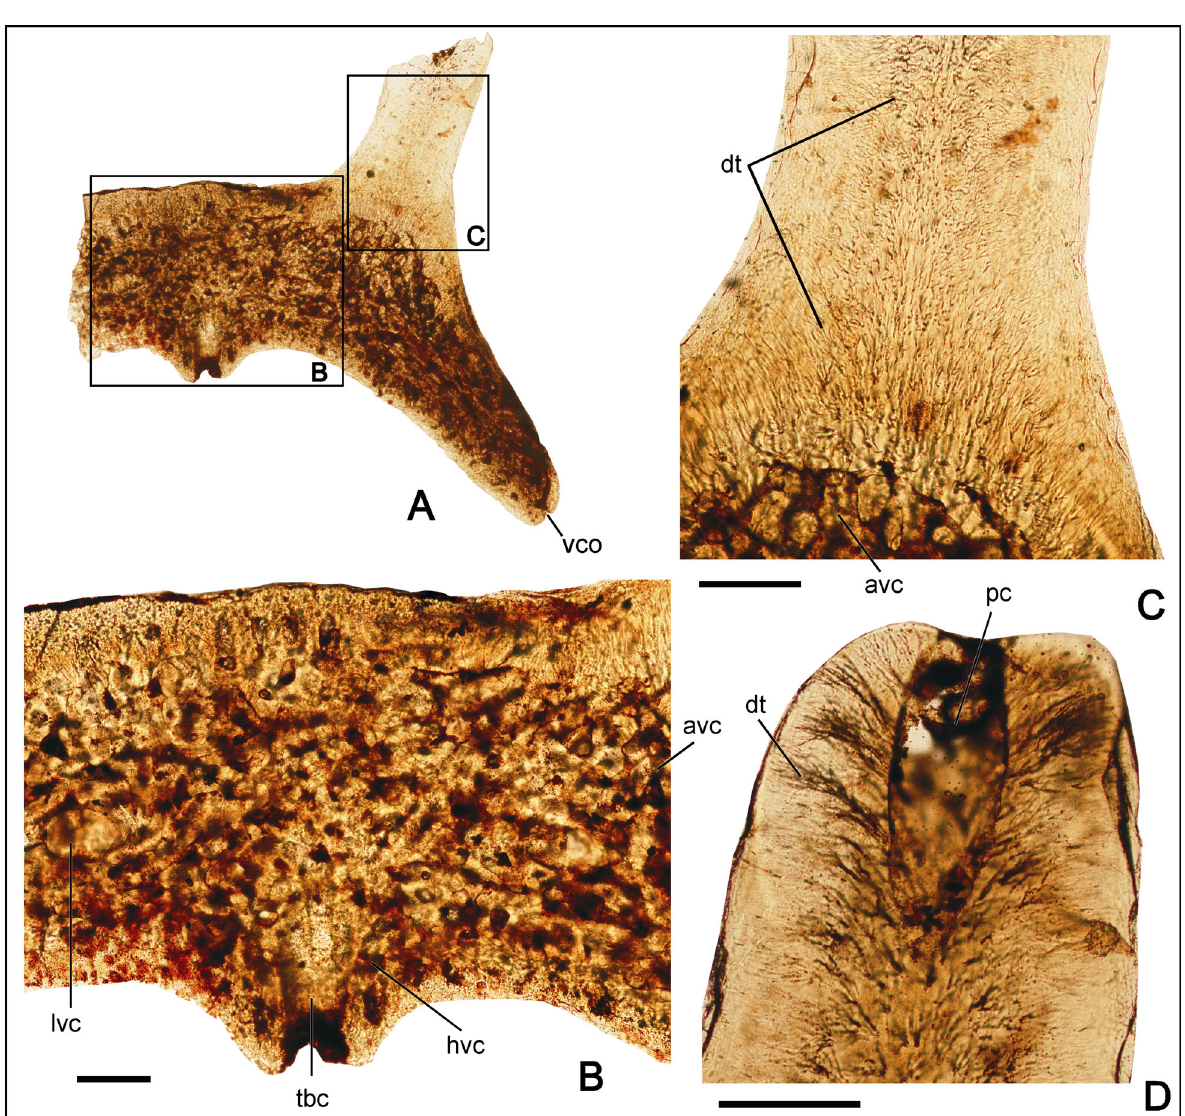
Fig. 4. Karksiodus mirus Ivanov & M(cid:228)rss, 2011, microstructure of tooth PM SPU 70-3, Kemka locality; Burtnieki Regional Stage. A , longitudinal section from the base and the lateral cusp (details in B and C shown by frames); B , detail of base microstructure; C , detail of the microstructure on the cusp/base boundary; D , detail of the microstructure of the cusp. Scale bars equal 100